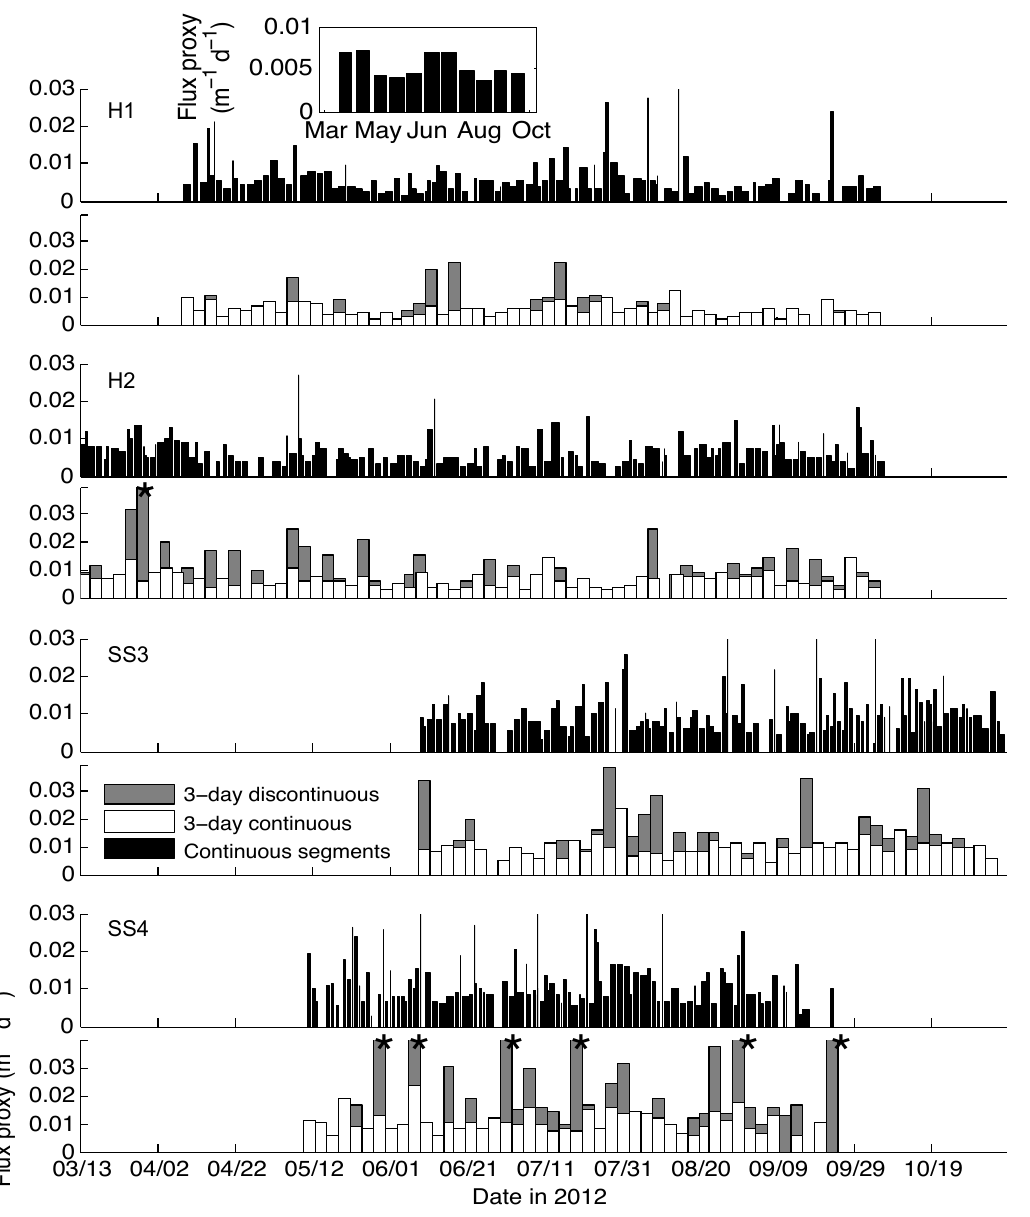
Fig. 4. Flux proxy time series for floats H1–SS4 (Table 1). Only flux data measured at 1000m depth and at least 1000m above the bottom are shown. Top panel in each pair shows flux as determined from individual segment fits (black; continuous component of flux proxy only). Bottom panel in each pair shows 3-day, bin-averaged flux from both continuous (white) and discontinuous (gray) components. Bar heights show flux magnitude; width shows time span. Bars marked with asterisks are off-scale. Note scale difference between upper and lower panel in each pair. Inset in rescaled, upper panel shows float H1 flux bin-averaged to 17days (see text).